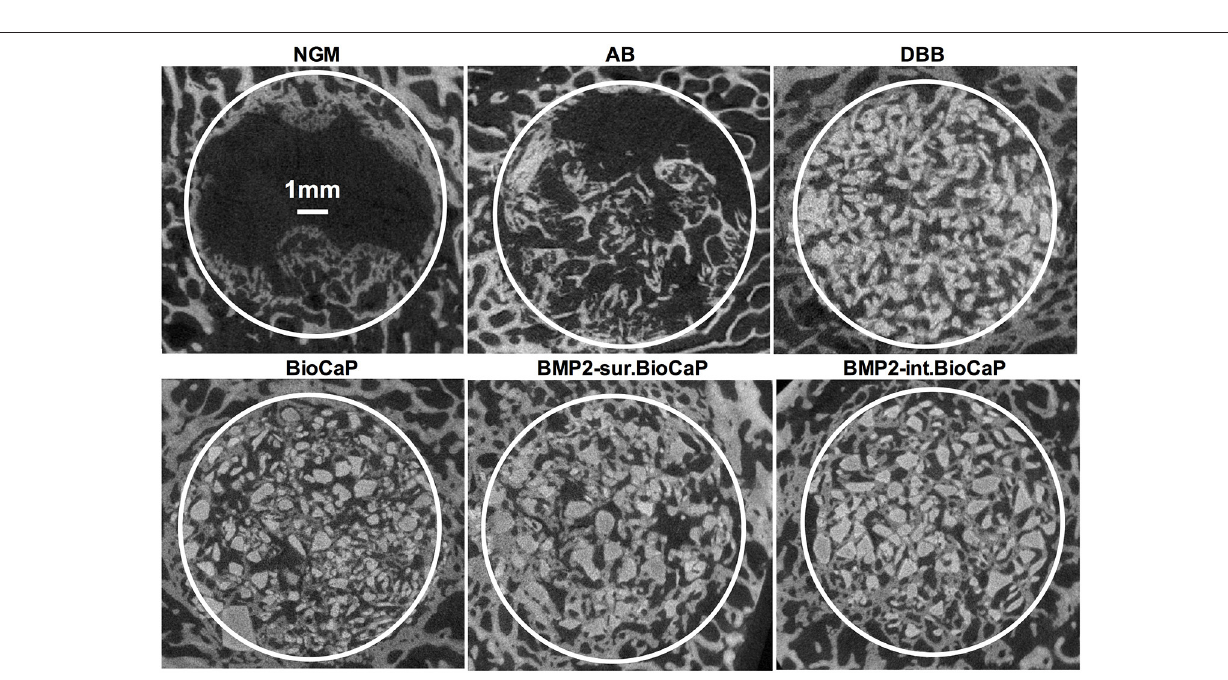
FIGURE 4 | Micro-CT images showing newly formed bone and grafted biomaterials in the defect site after 8 weeks of grafting.